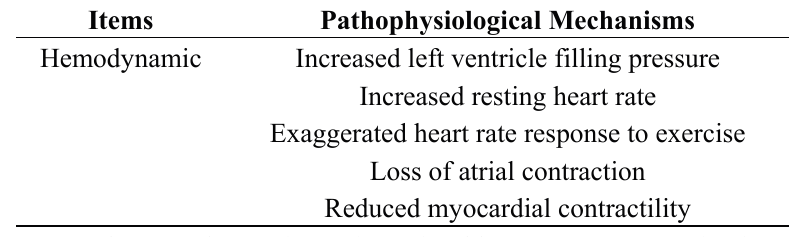
Table 1. Common pathophysiological mechanisms of heart failure and atrial fibrillation.